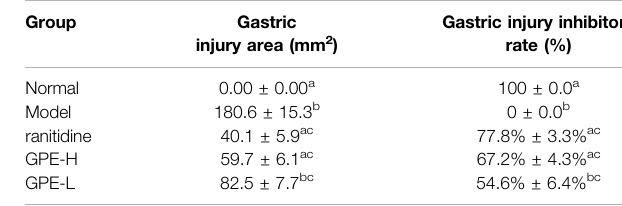
TABLE 3 | The gastric injury area and gastric injury inhibitory rate of